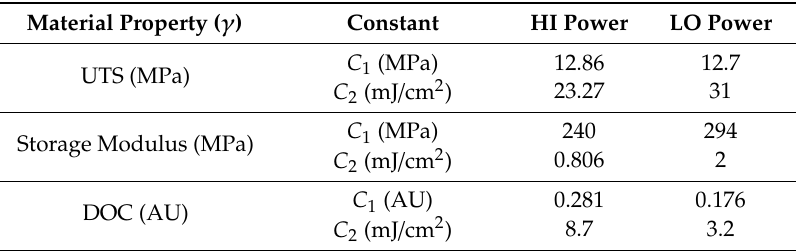
Figure 12. ( a ) Effect of exposure time and layer thickness on accumulated energy, Relation between accumulated energy per layer 𝐸 𝑇 and ( b ) Ultimate tensile strength, ( c ) Storage modulus, ( d ) DOC. Table 3. Constants values for material property regression model.